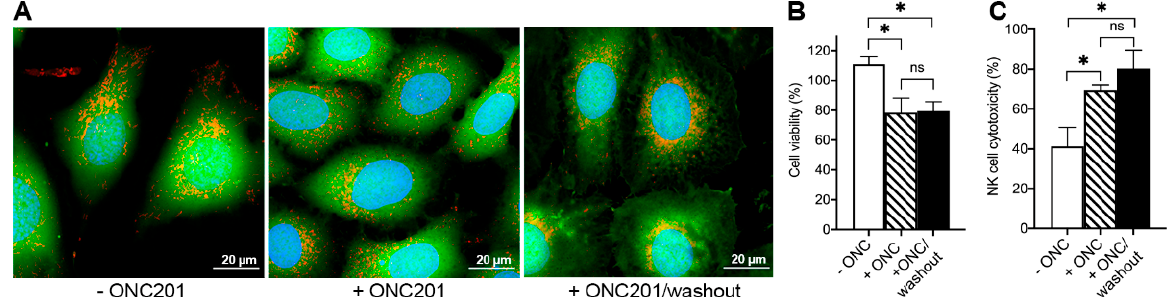
Figure 7. Long-term ONC201 treatment increases the susceptibility of BT474 cells to TRAIL (DR5b) and NK-cells induced killing. ( A ), Confocal images of BT474 before treatment with ONC201 (- ONC201), after 72 h with 10 µM ONC201 (+ONC201), and after subsequent 5-day washout (+ONC201/washout). Cells were loaded with 2 µg/mL Hoechst 33,342 (blue, nuclei), 1 µM Calcein- AM (green, cytoplasm), and 150 nM MitoTracker Deep Red (red, mitochondria); ( B ), Viability of BT474 cells pre-treated with ONC201 as in panel ( A ) and subsequently treated with 1000 ng/mL TRAIL for 24 h; C, NK cell cytotoxicity toward BT474 (pretreated with ONC201 as in panel ( A )). * p < 0.05, “ns”,